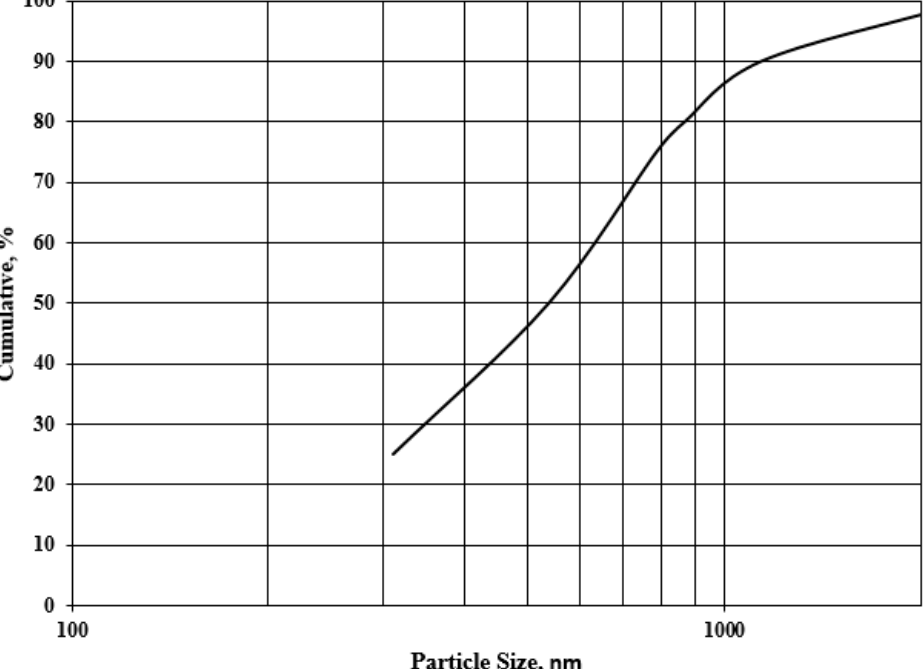
Figure 3. Particle size distribution of EAFS.